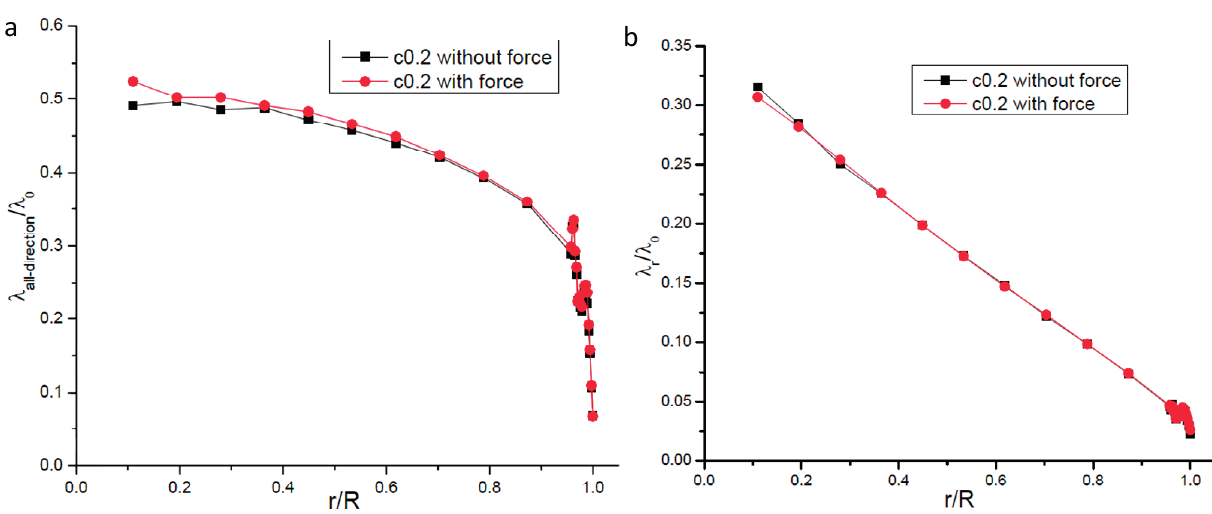
Figure 9. Comparison of simulation results whether the body force is added on every gas molecule. ( a ) gas molecular mean free path including all directions’ collisions; ( b ) radial gas molecular mean free